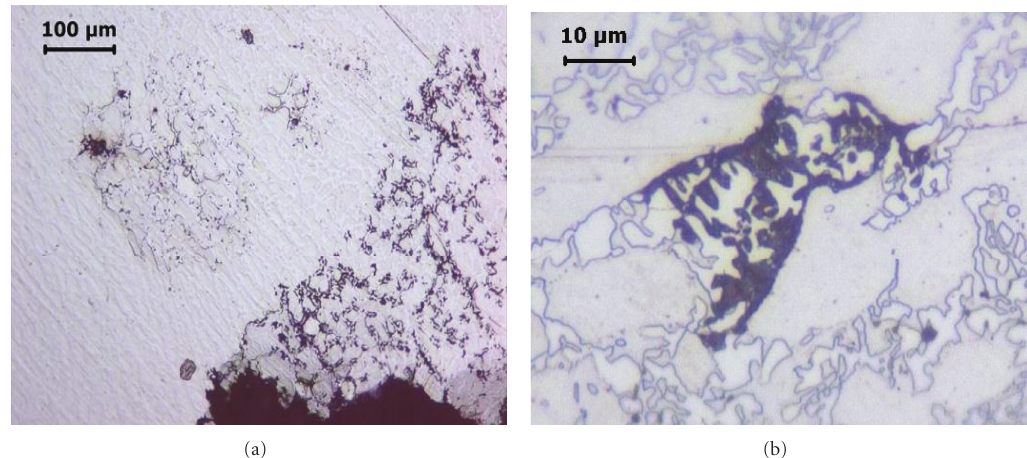
Figure 5: Corroded area of the aged specimen at 800 ◦ C/31622min after the standard immersion test for 24 hours. (a) Large initiated areas of localized corrosion (black) and big cavities are formed. (b) The corrosion propagates within the secondary austenite (slightly etched with oxalic acid) adjacent to the sigma